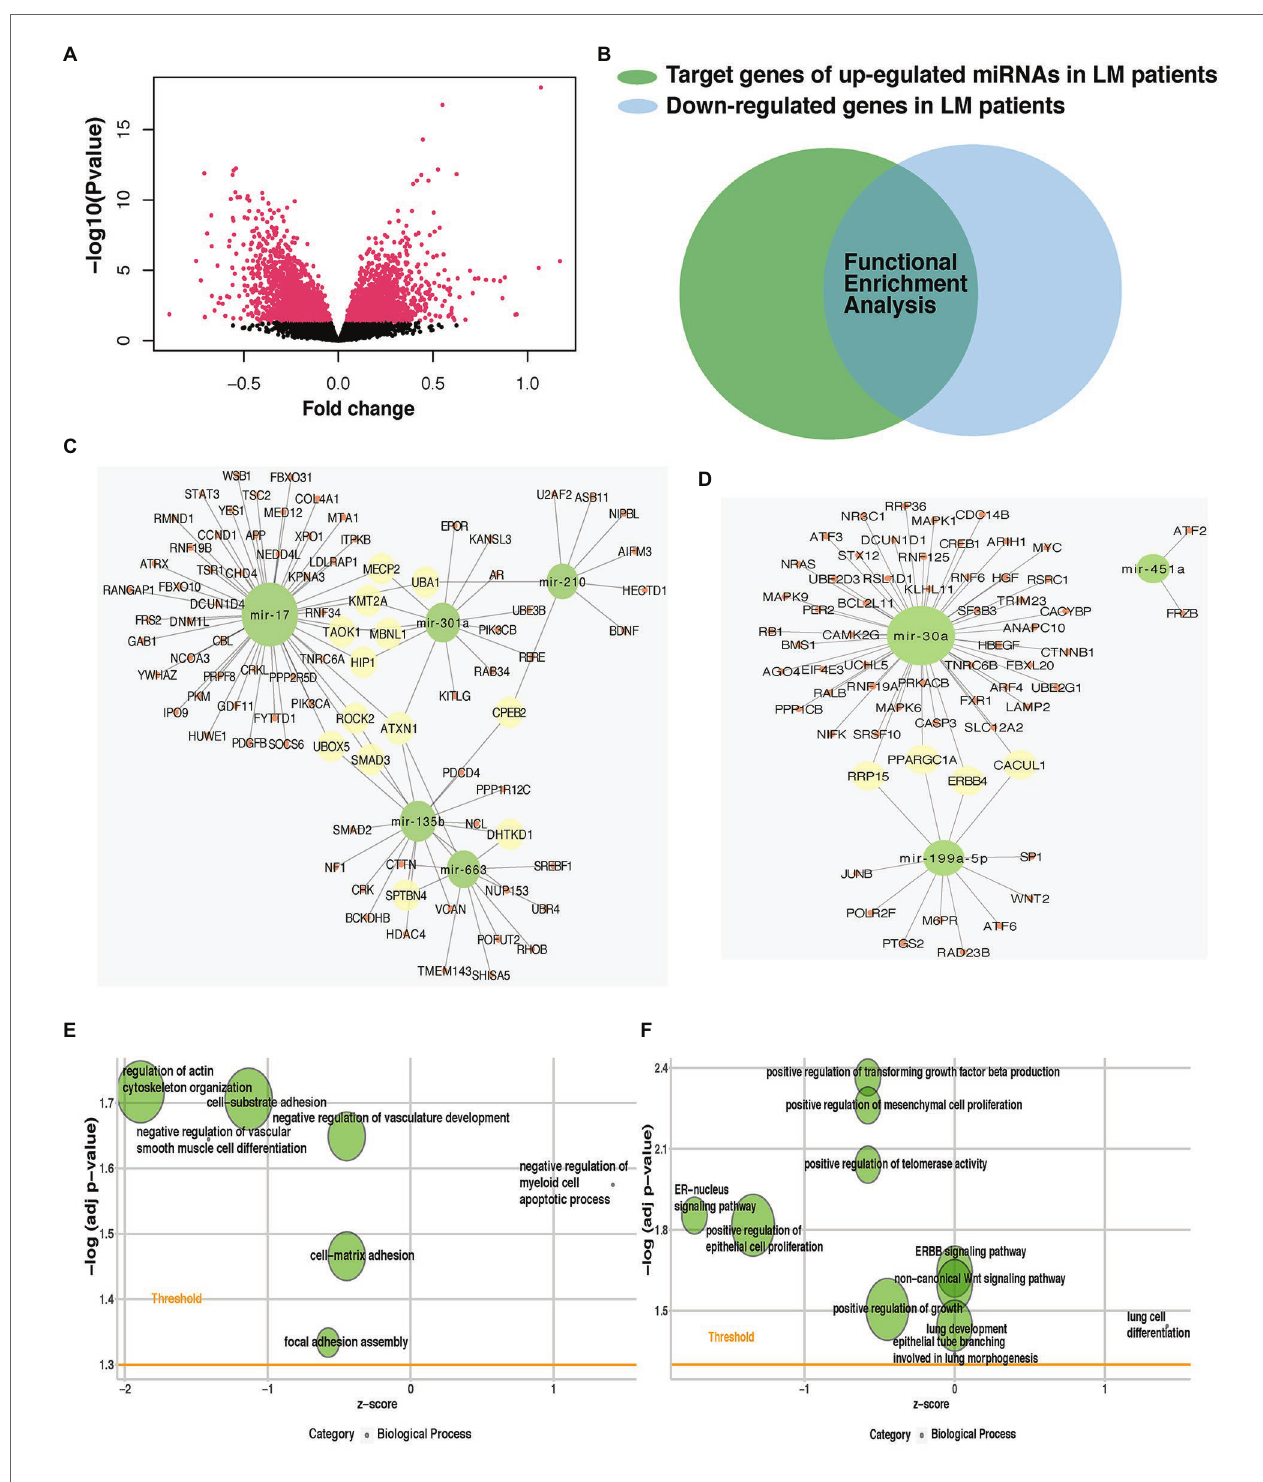
FIGURE 6 | Identification of potential targets for predictive miRNAs and their role in lung metastasis. (A) Volcano plot of mRNAs expression in the METABRIC dataset. (B) Venn diagram was plotted to show the overlap between differentially expressed mRNAs (DEmRNAs) and gene targets for predictive miRNAs. The overlap of each predictive miRNA was used in subsequent analysis. miRNA-mRNA interaction networks of the hub genes of (C) five upregulated or (D) three downregulated predictive miRNAs. Enriched metastasis-related gene ontology (GO) terms of the hub genes of (E) five upregulated or (F) three downregulated predictive miRNAs. miRNA, microRNA; METABRIC, molecular taxonomy of breast cancer international consortium; DEmRNAs, differentially expressed mRNAs; and GO, gene